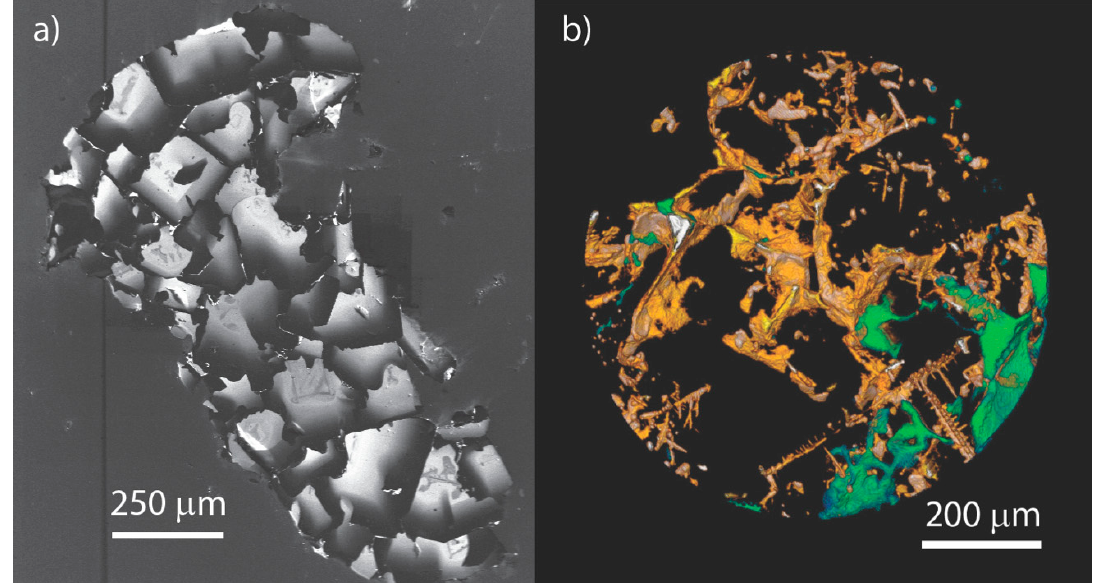
Figure 1. ( a ) Cathodoluminescence (CL) image of a corundum aggregate showing intense zoning related to Ti 3+ concen- tration. Pale areas with skeletal structure have low contents of Ti and pale pink CL, which is progressively extinguished as Ti concentrations rise toward grain boundaries and pockets of trapped silicate melts. ( b ) A 3D-µCT image of a slice through a corundum aggregate. Black = corundum crystals; green = void spaces; orange = silicate melts; brighter colors = silicides and Ti nitrides.